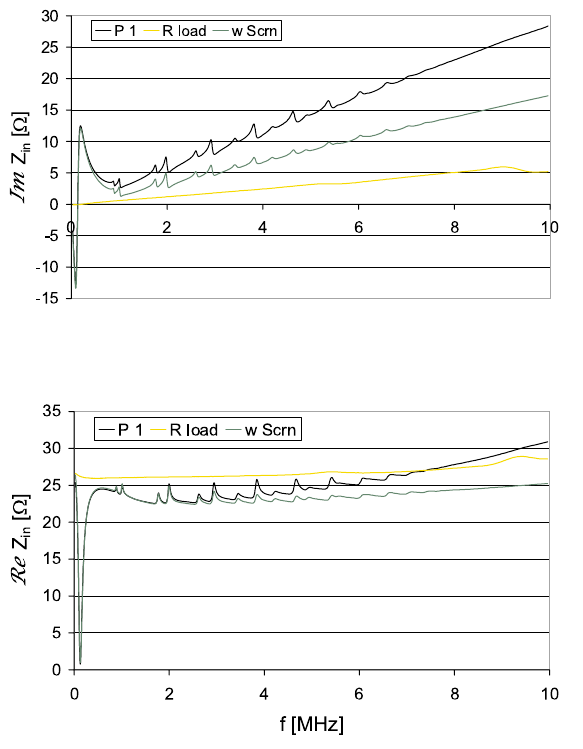
FIG. 18. (Color) Impedance seen at the busbar of the magnet with